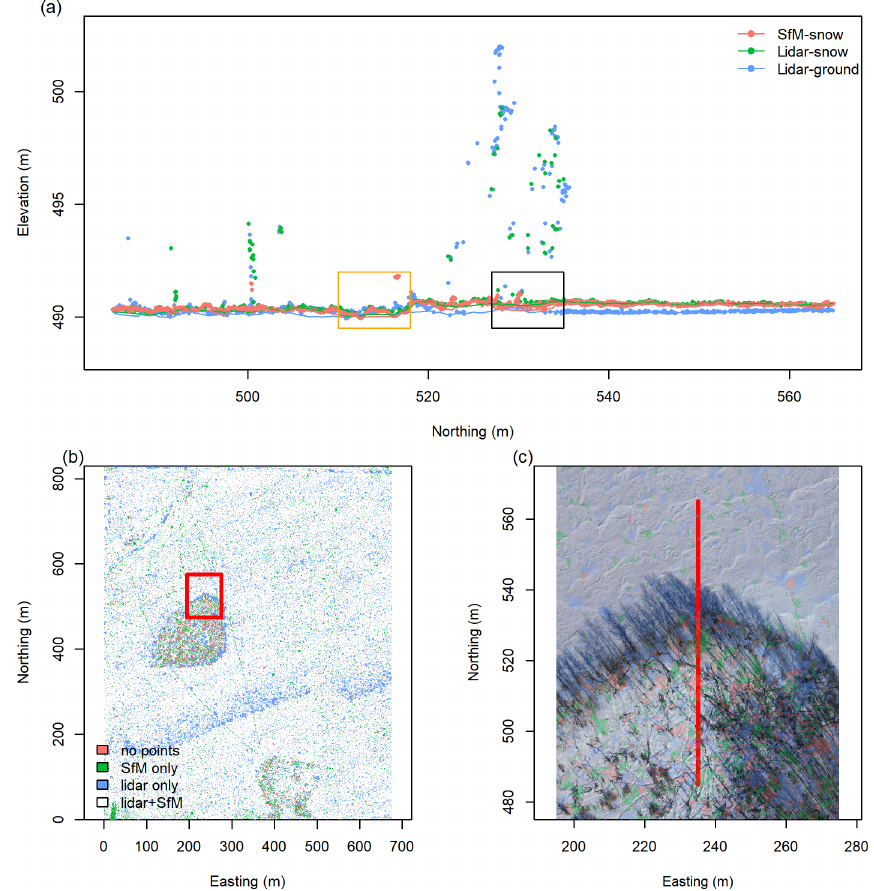
Figure 8. Rosthern (18 March 2019) study site with an example (a) cross section with all points and the interpolated vegetation-free surface (lines) for SfM-snow (red), lidar-snow (green), and lidar-ground (blue) surveys. The study area is classified by areas with greater than 1pt per 0.25m − 2 in (b) with respect to point clouds obtained from UAV-lidar and UAV-SfM techniques. In (a) the black polygon highlights areas of dense shrubs while the orange polygon highlights interpolation artefacts of UAV SfM. The red inset polygon in (b) identifies the area of the orthomosaics displayed in (c) with the same overlain transparent point type classification colour scheme as shown in (b) . The red line in (c) corresponds to the cross section plotted in (a)